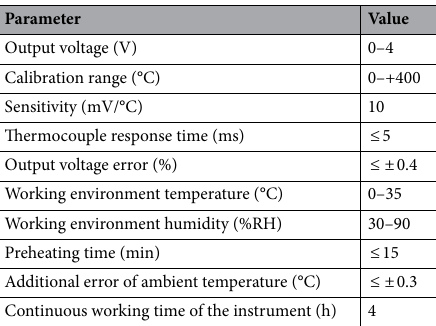
Table 2. Technical parameters of the thermocouple sensor.